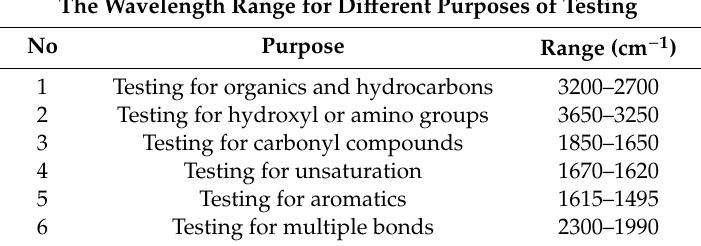
Table 2. Steps to analyze